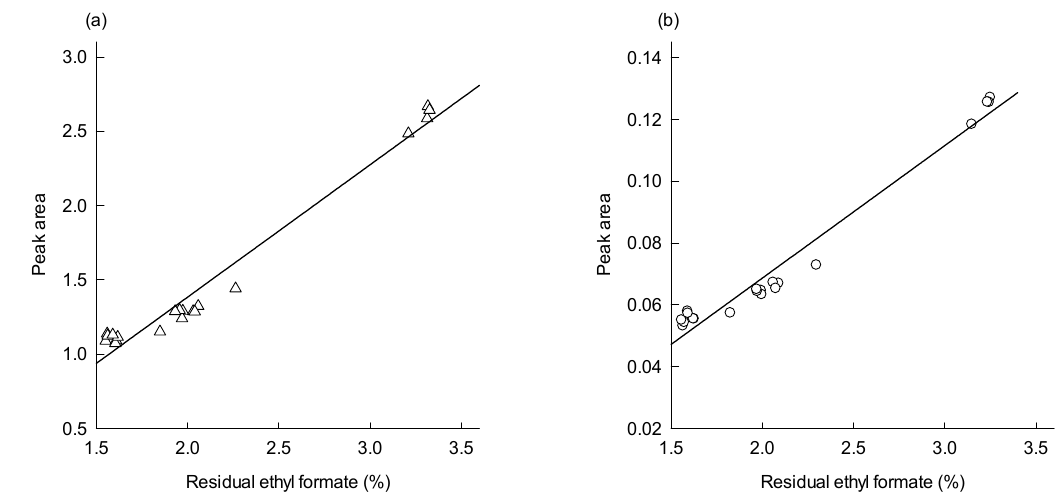
Figure 7. Linearity between the content of residual ethyl formate and the solvent peak area. The first derivative data with respect to ( a ) minutes and ( b ) degrees Celsius were utilized to compute the peak area of ethyl formate.